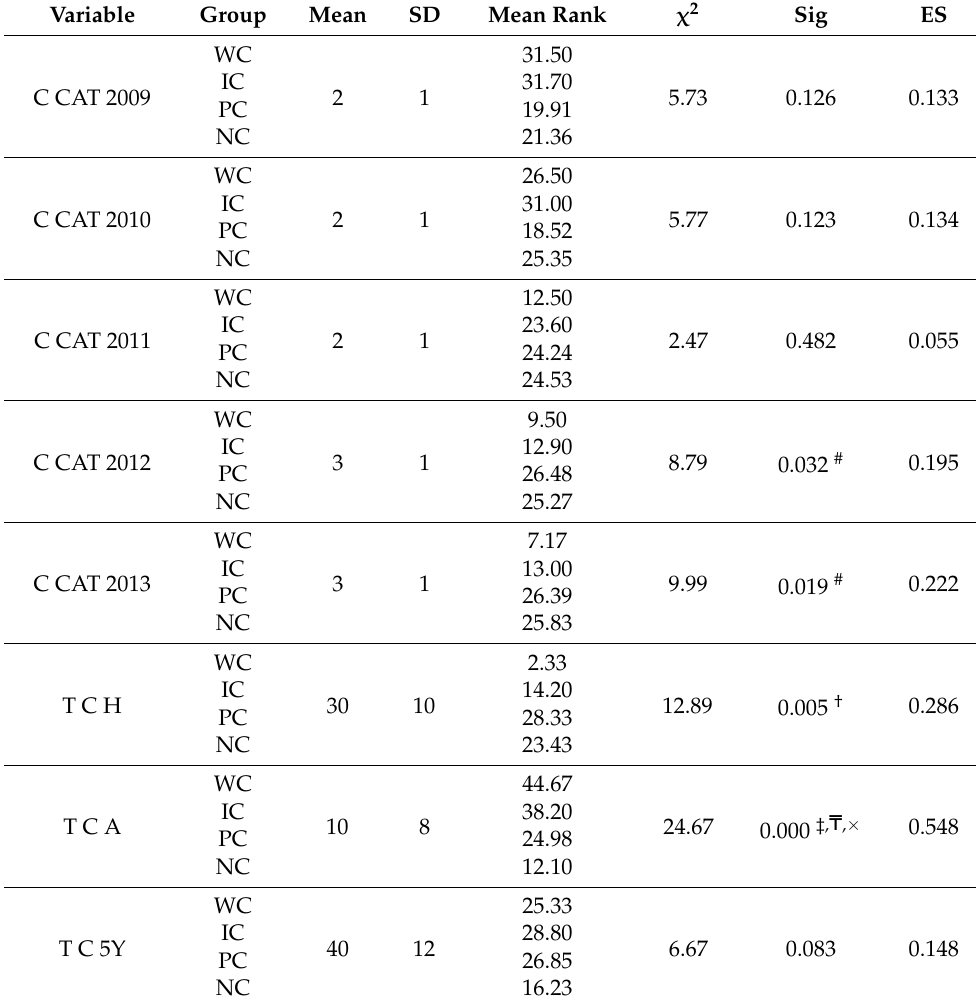
Table 3. Difference between Categorisation groups for the number of competition categories and competition distribution in selected years with Kruskal–Wallis test and effect size.